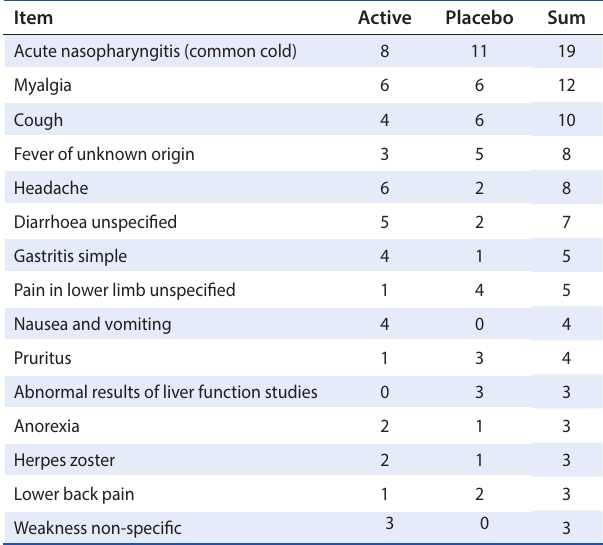
Table 4: Number of patients per treatment arm that reported adverse